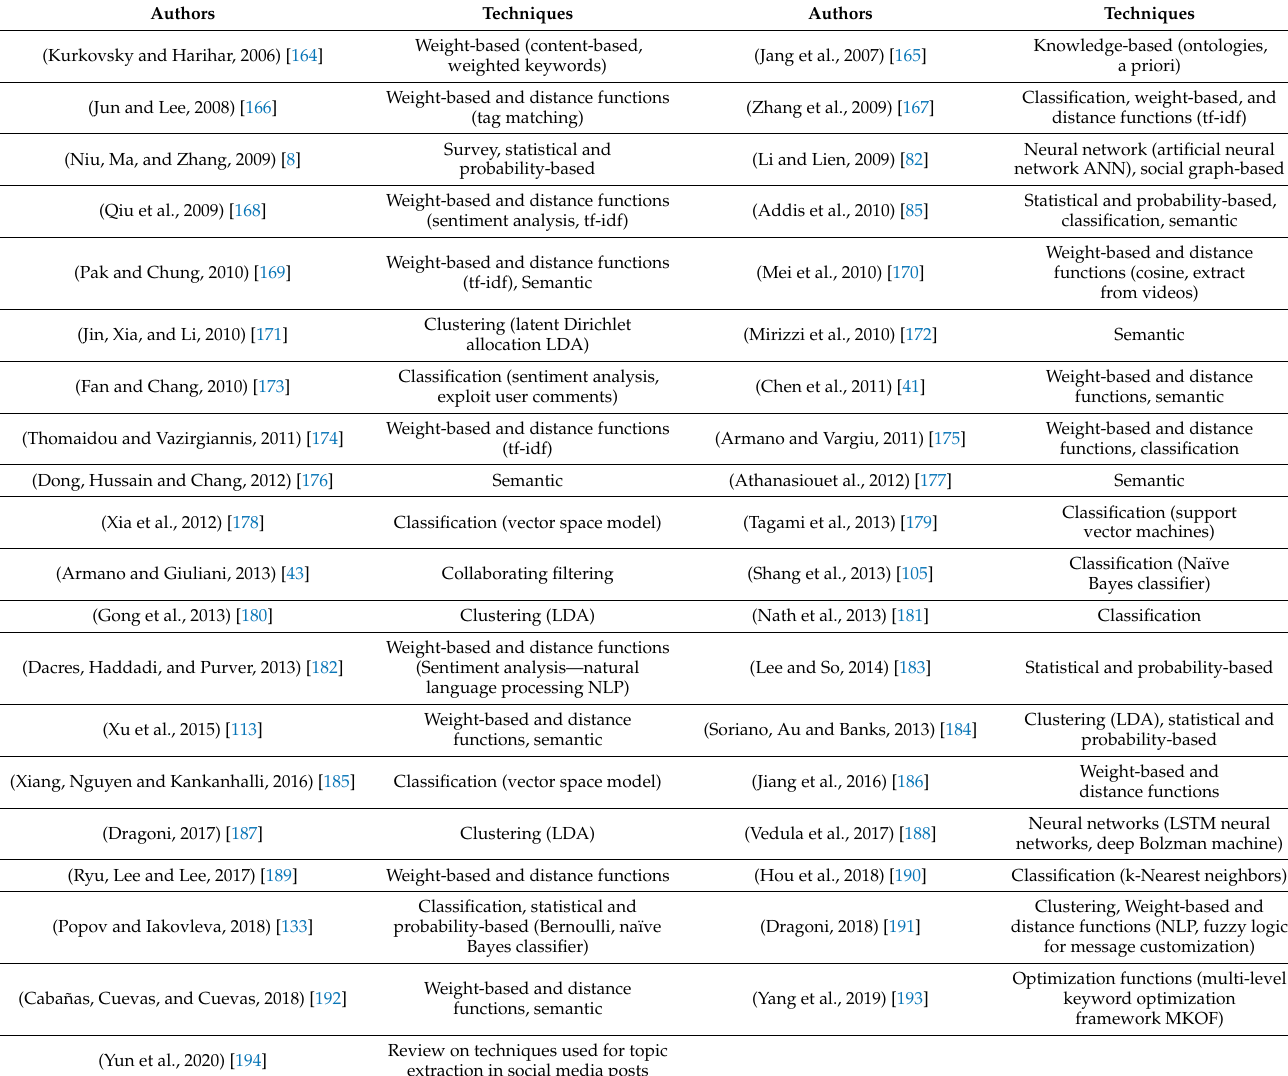
Table A2. Content-based analysis and text matching related